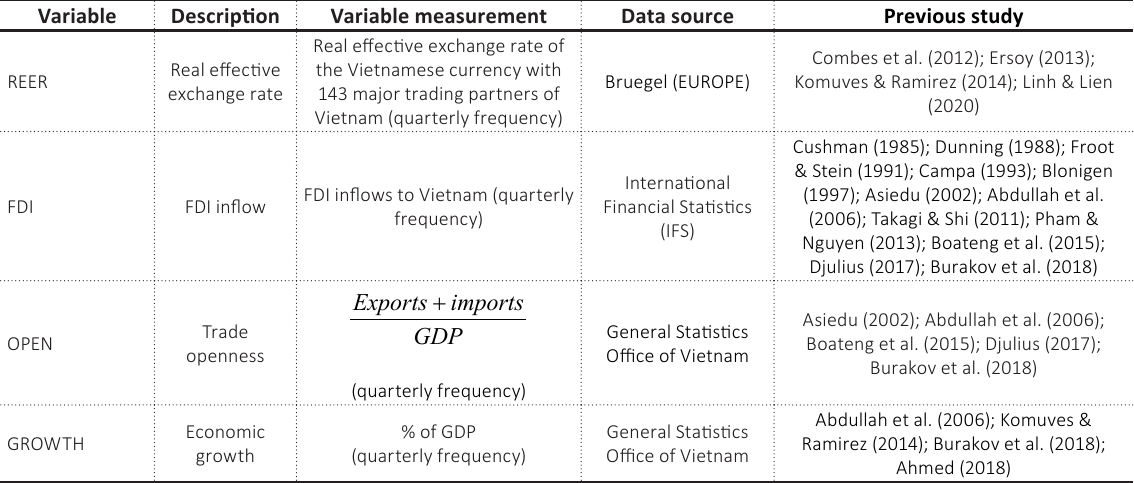
Table 1. Variables used in the research model